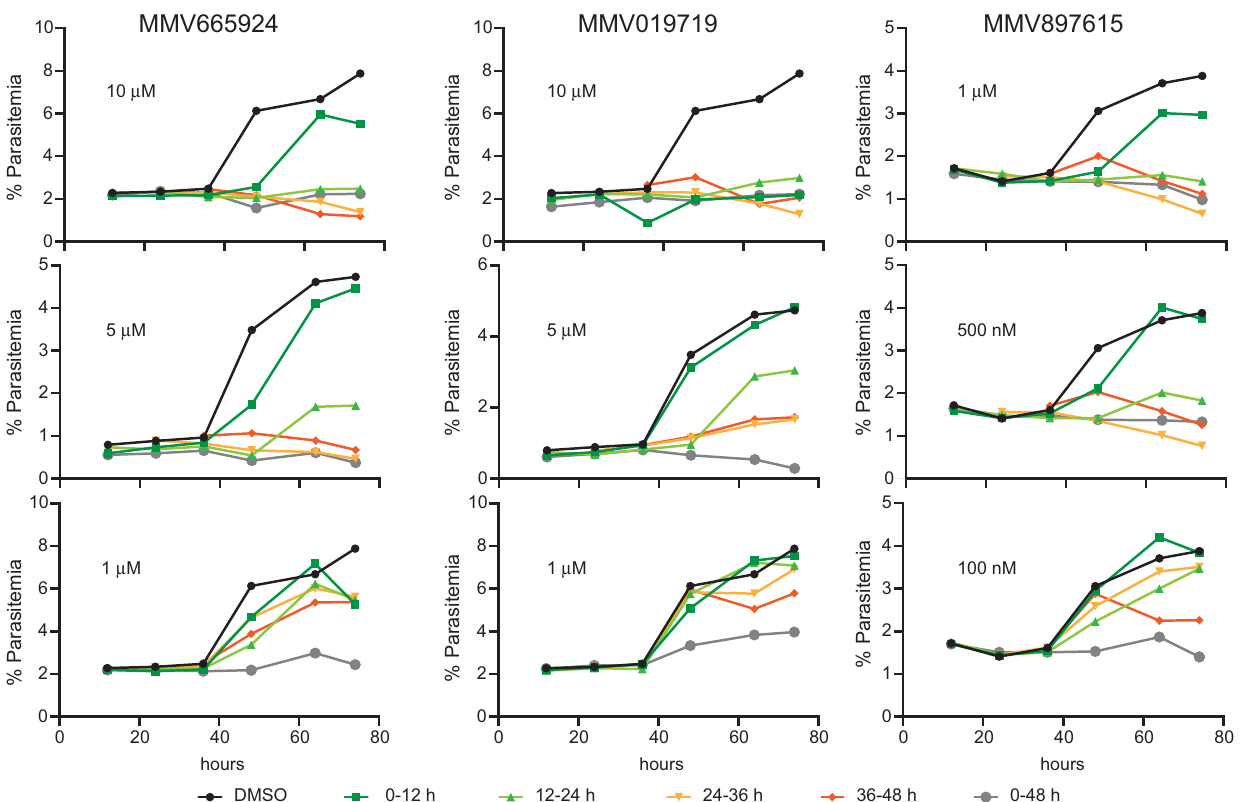
Fig.9|MMV019719,MMV665924,andMMV897615aremostactiveagainstlate- stage parasites. 0 – 6h old parasites were exposed for 12h windows to three dif- ferent concentrations of compound (low, intermediate, and high). Smears were taken before addition of the drug (start) and every 12h after drug exposure. Representative images for the intermediate concentration are shown in Supple- mentary Fig. 4. The parasitemia was measured by fl ow cytometry every 12h and into the second lifecycle to determine viable parasites, as indicated by an increase in parasitemia. Parasitemia can be seen to increase at 48h in the untreated DMSO